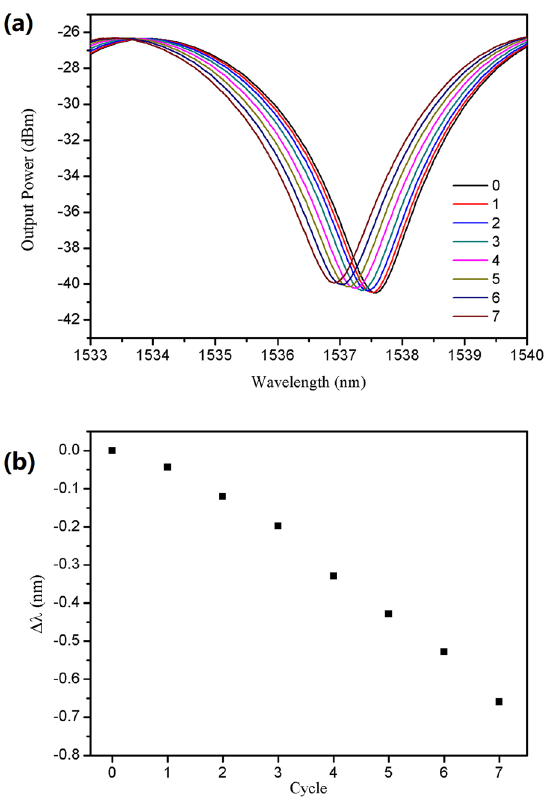
Figure 9: The spectra of Mach – Zehnder interferometer (MZI) and central wavelength changes for each